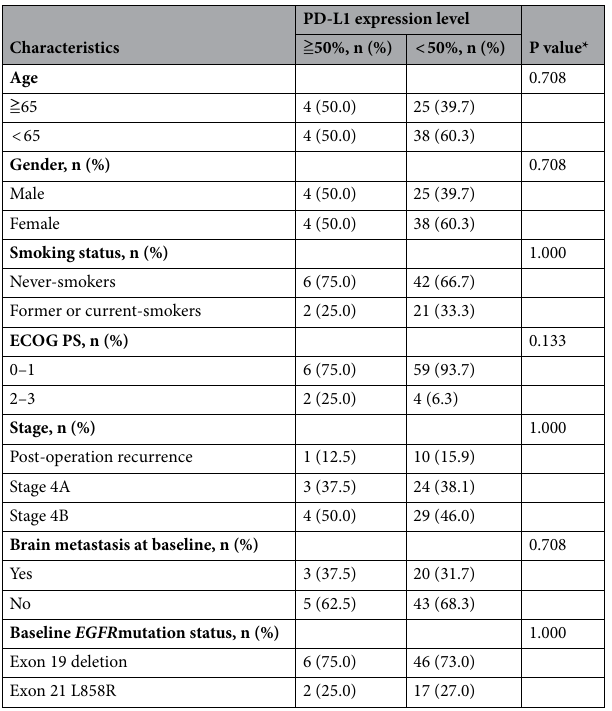
Table 4. The patients’ characteristics in different groups of PD-L1 expression levels (n = 71). PD-L1, Programmed death-ligand 1; ECOG PS, Eastern Cooperative Oncology Group performance status; EGFR, epidermal growth factor receptor. *By Fisher’s exact